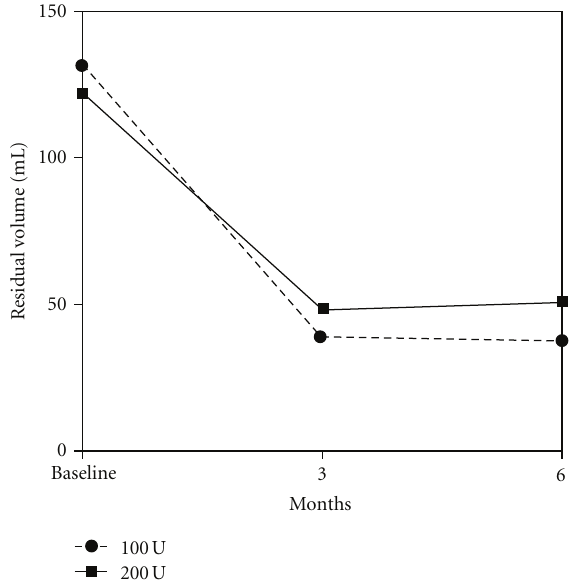
Figure 3: Mean PVR of 34 patients treated with 100 and 200U of intraprostatic